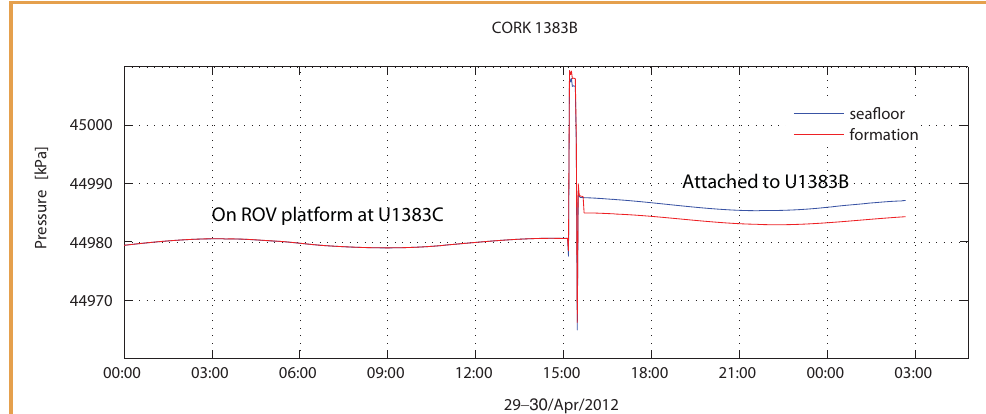
Figure 6. Pressure data from the CORK-Lite at IODP Hole 1383B. Before the instrument was attached, both sensors monitored bottom seawater on the ROV platform at Hole U1383C. After attachment, the two readings are different, signifying that the borehole is sealed and under-pressured relative to bottom